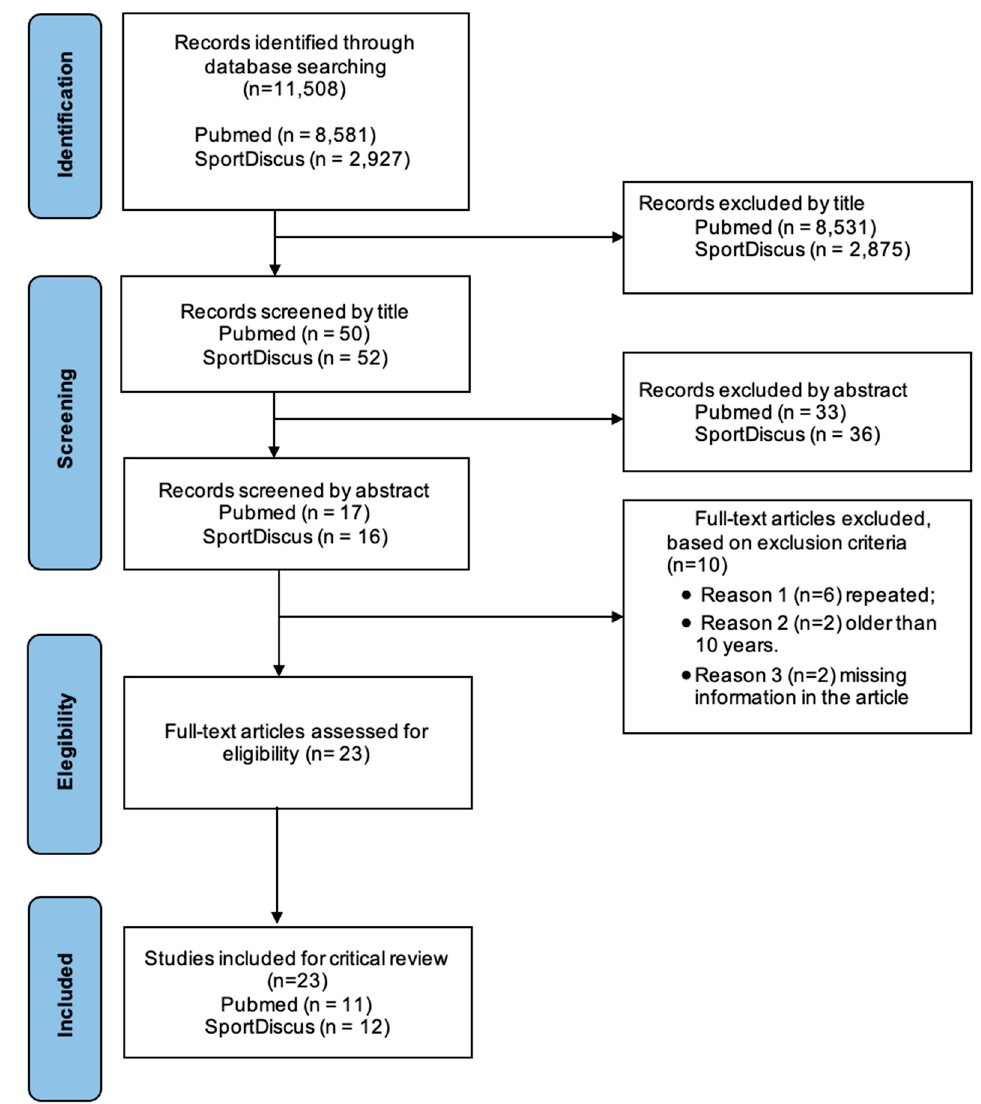
Figure 1. PRISMA diagram detailing the search process.